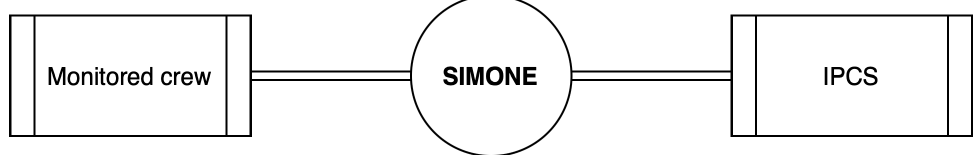
Figure 2. Data flow diagram (DFD, level 0). Functionality of the proposed